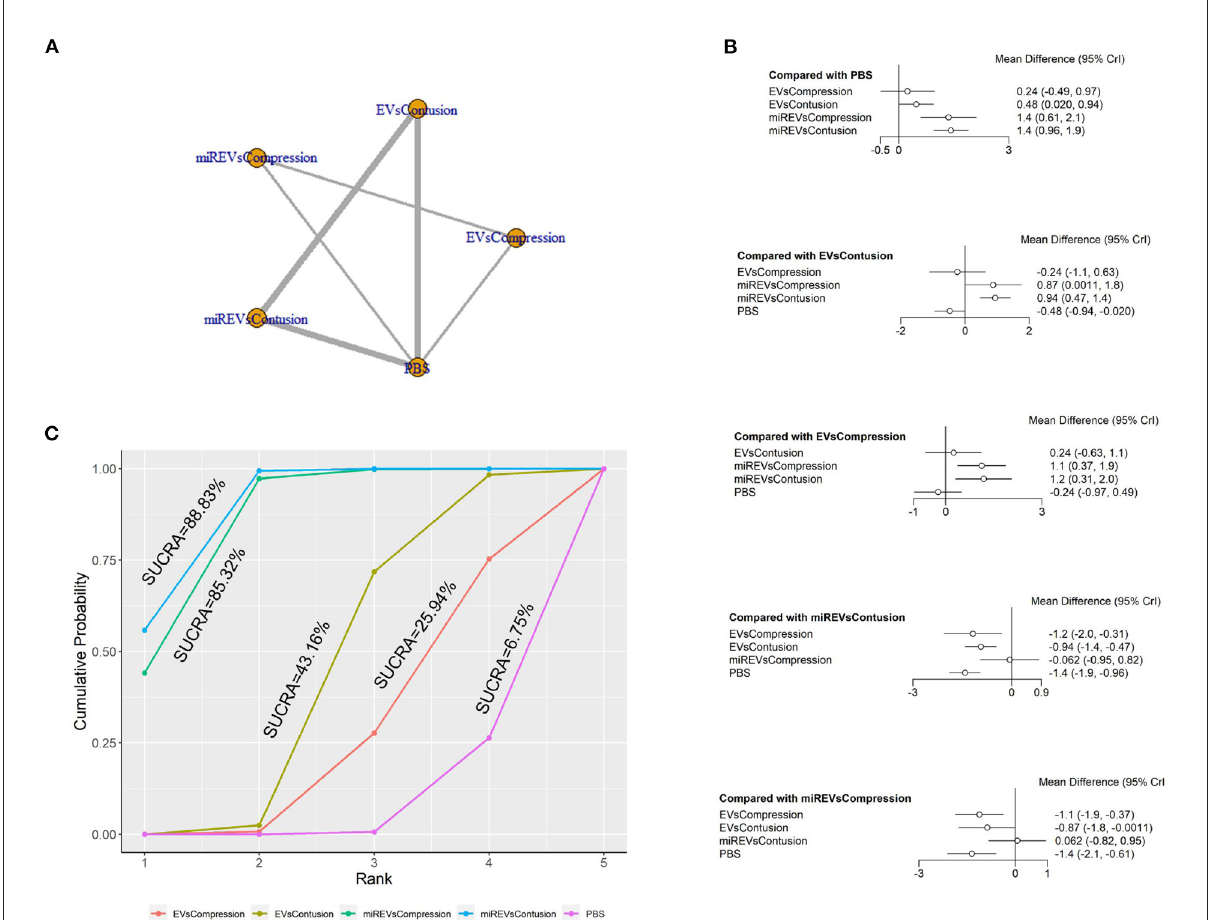
FIGURE7 The network meta-analysis of BBB scores in different models at 3 days after administration. (A) Network plot; (B) Forest plot; (C) SUCRA plot. EVsCompression, EVs in compression models; EVsContusion, EVs in contusion models; miREVsCompression, miRNAs-loaded EVs in compression models; miREVsContusion, miRNAs-loaded EVs in contusion